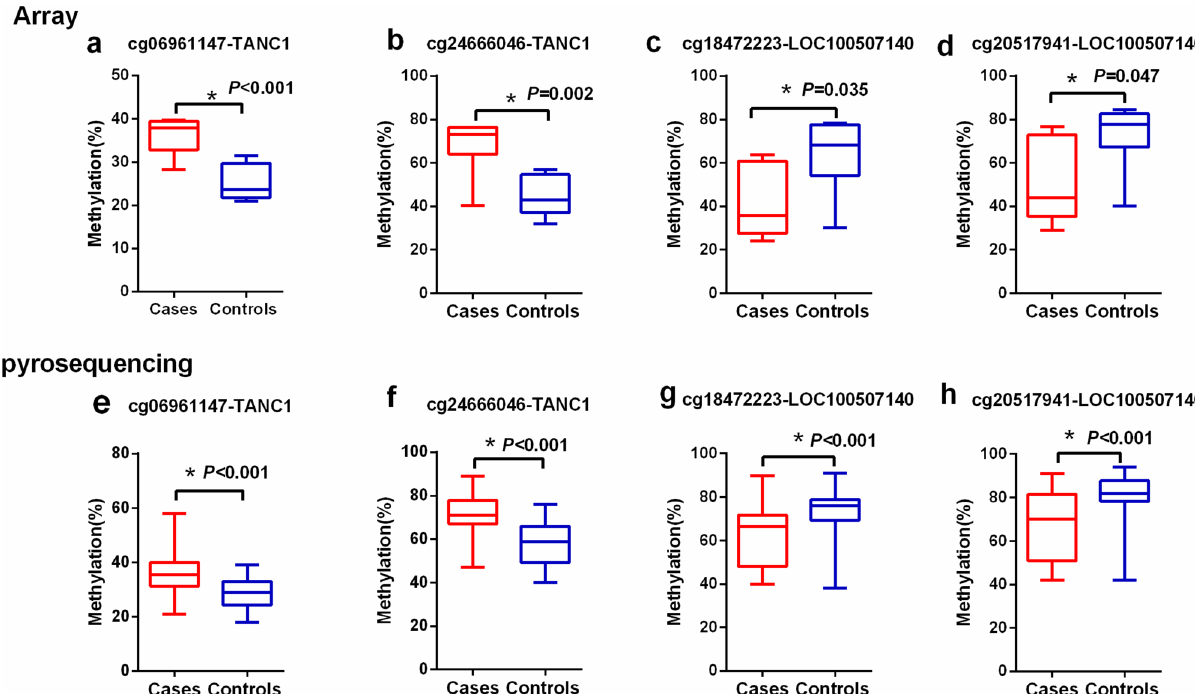
Figure 5. DNA methylation values of four CpGs sites measured by the EPIC BeadChip (top) and by bisulfite pyrosequencing (bottom). DNA methylation values of cg06961147 (a) , cg24666046 (b) , cg18472223 (c) , and cg20517941 (d) were measured using EPIC BeadChip. DNA methylation values at each CpG site by percentage were measured by pyrosequencing of the ADLI patients (red) and controls (blue) in cg06961147 (e) , cg24666046) (f) , cg18472223 (g) , and cg20517941